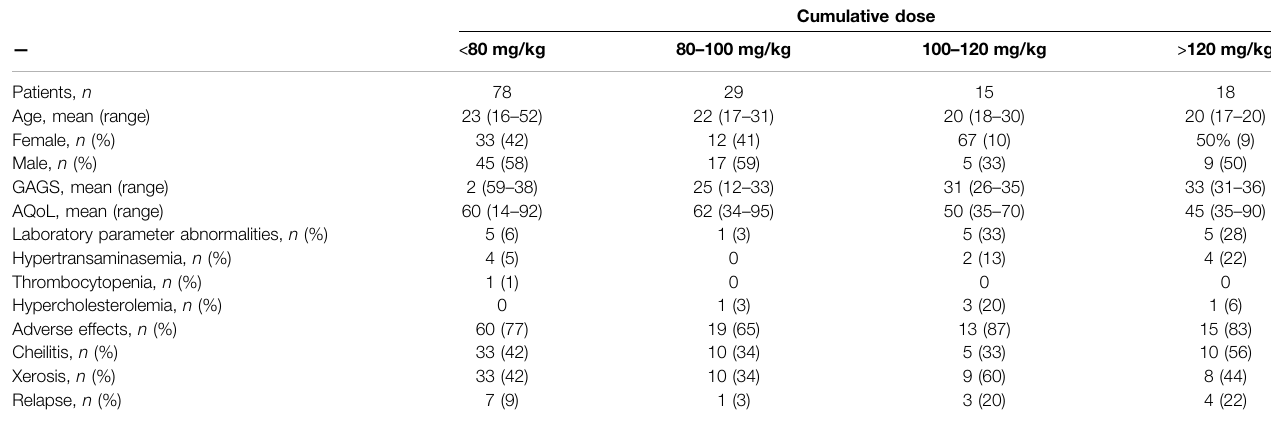
TABLE 1 | Cumulative